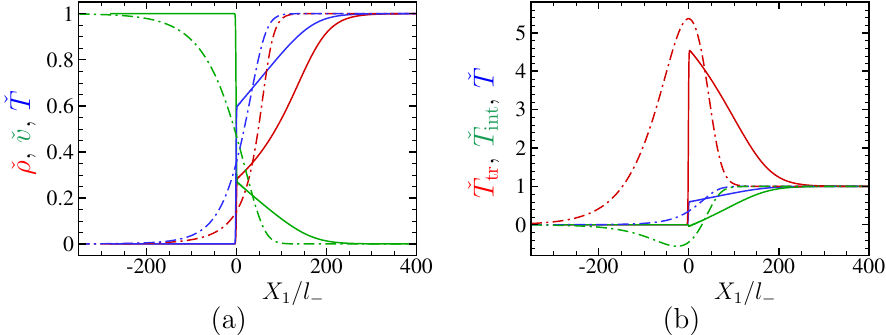
Figure 12. Profiles of ˇ ρ , ˇ v , ˇ T , ˇ T tr , and ˇ T int in the case of SF 6 gas at M − = 3. ( a ) ˇ ρ , ˇ v , and ˇ T ; ( b ) ˇ T tr , ˇ T int , and ˇ T . See the caption of Figure 2.